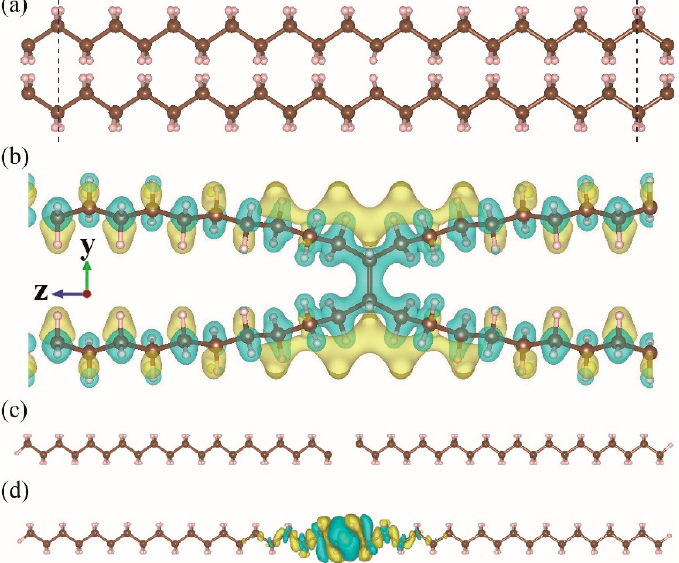
Figure 4. (Color online) The initial ( a ) and relaxed ( b ) structures of two infinitely long hydrocarbon chains in parallel along the z -axis. The two dotted lines in ( a ) show the borders of the supercell along the z direction. For each hydrocarbon chain, one hydrogen atom in the supercell is removed. Brown and pink spheres represent the carbon and hydrogen atoms, respectively. The charge-density dif- ference is also given for the relaxed structure in ( b ). The green and yellow colors illustrate the elec- tron accumulation and depletion regions, respectively. ( c , d ) are the initial and relaxed structures of two finitely long molecules (C 20 H 42 ) in ‘head-to-head’ cross-linking mode. The charge-density dif- ference for the relaxed structure is also given in ( d ). For each molecule, one hydrogen atom is re- moved.